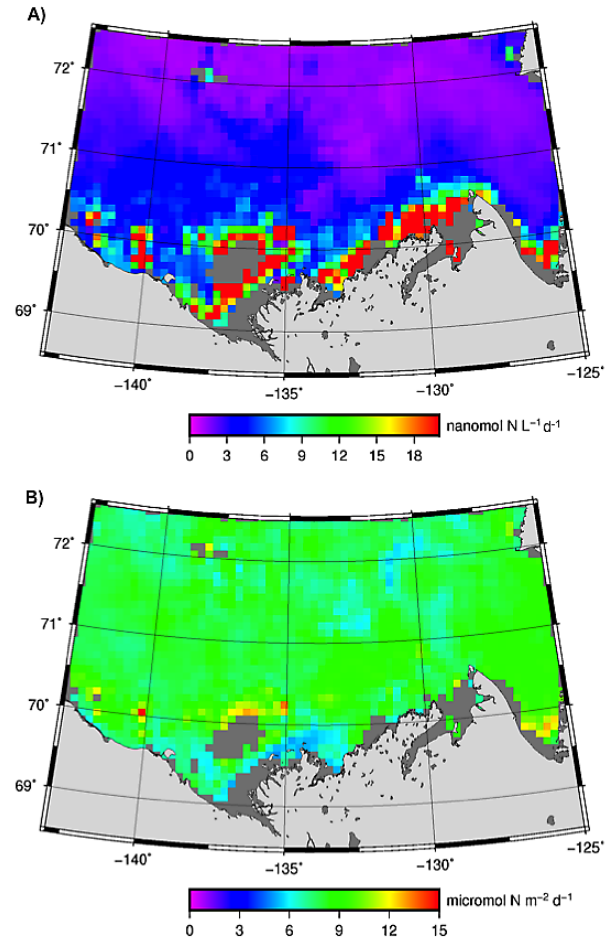
Fig. 9. Contour maps of modeled NH + photoproduction rates at the 4 sea surface ( P , A ) and in the entire water column ( P , NH + 4 , 0 NH + 4 , col B ) in August 2009. Grey color denotes lack of satellite ocean color data due to sea ice, persistent cloud cover or extreme